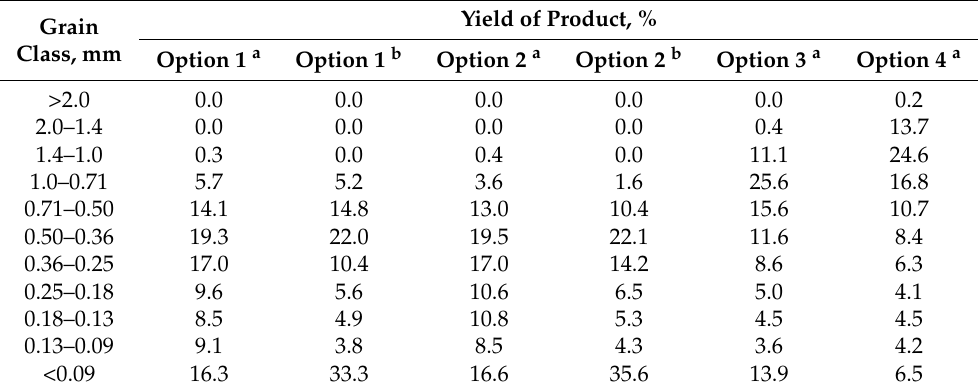
Table 1. Yield of grinding product grain classes.